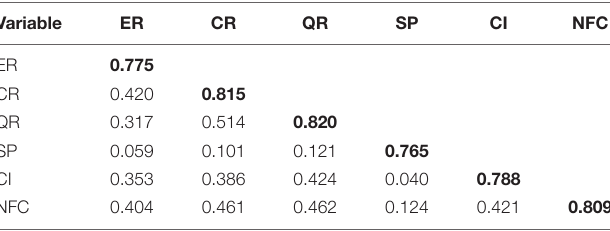
TABLE 3 | Square root of AVE and correlation coefficient